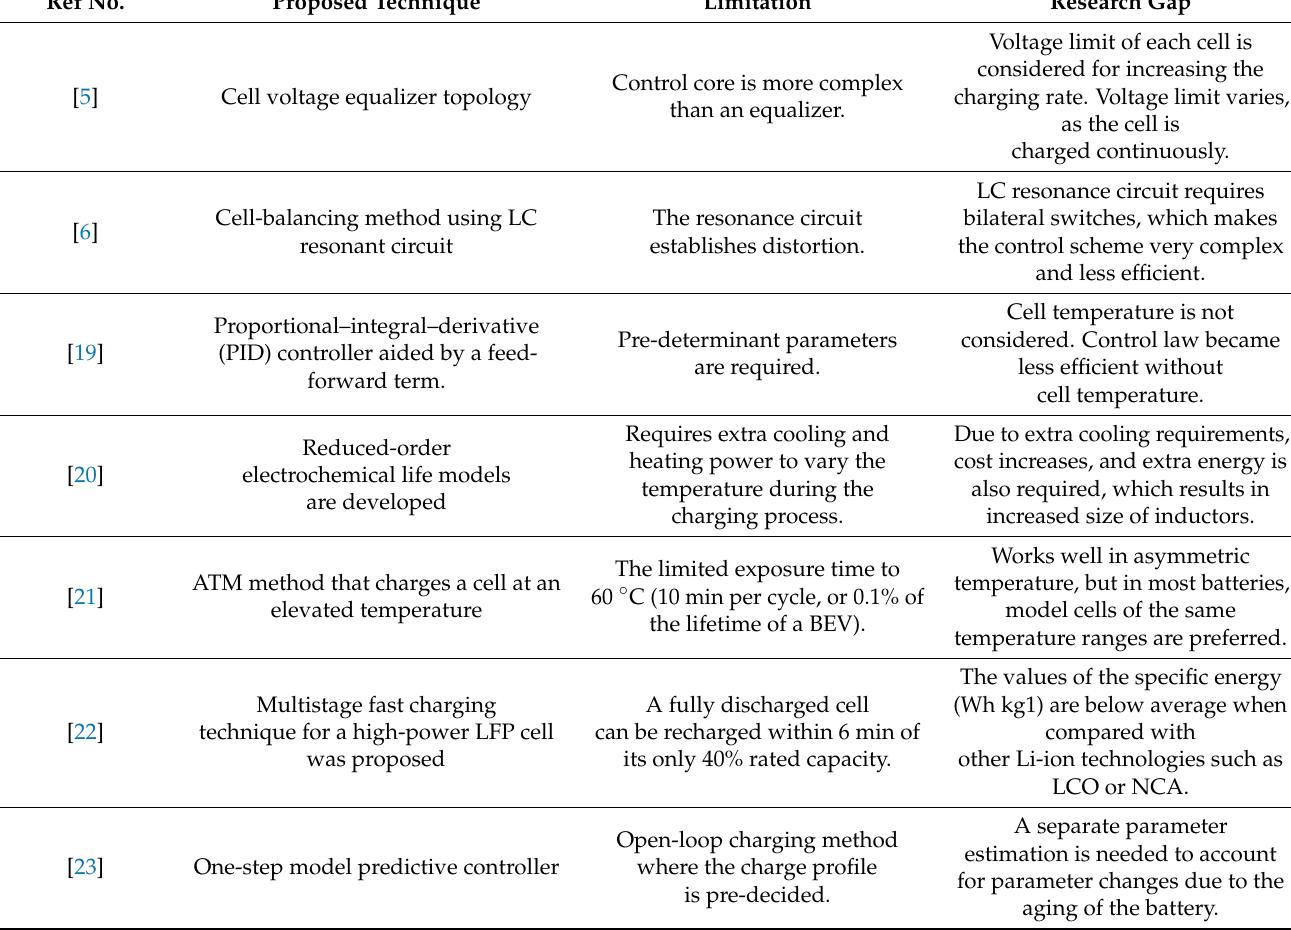
Table 1. Comparative analysis of existing techniques and research gap identification. Ref